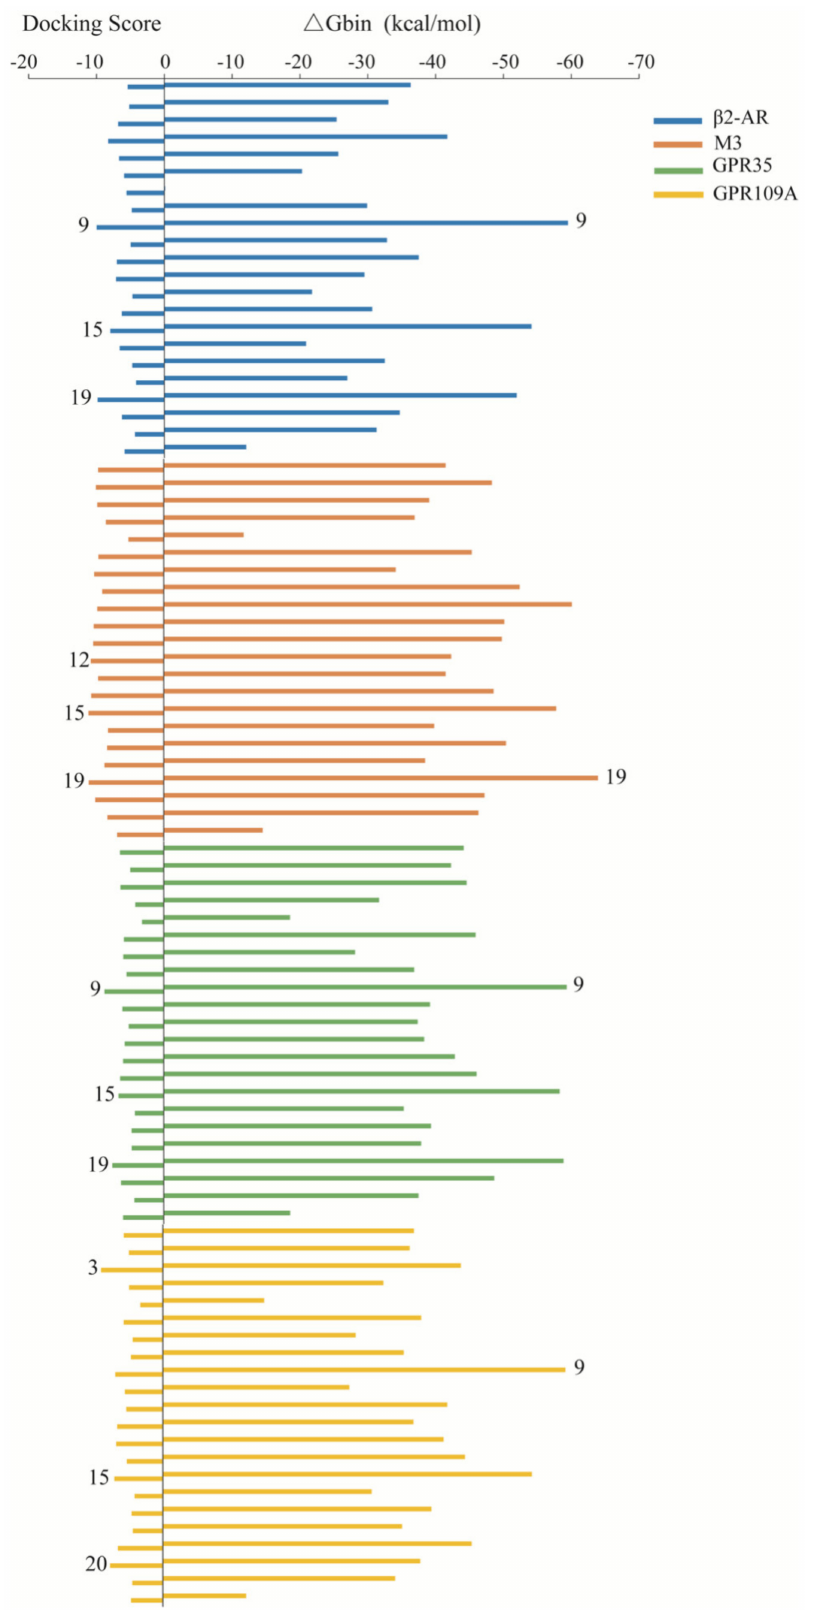
Figure 6. Docking scores and binding free energies of the 22 identified compounds to β 2 − AR, M3, GPR35 and GPR109A